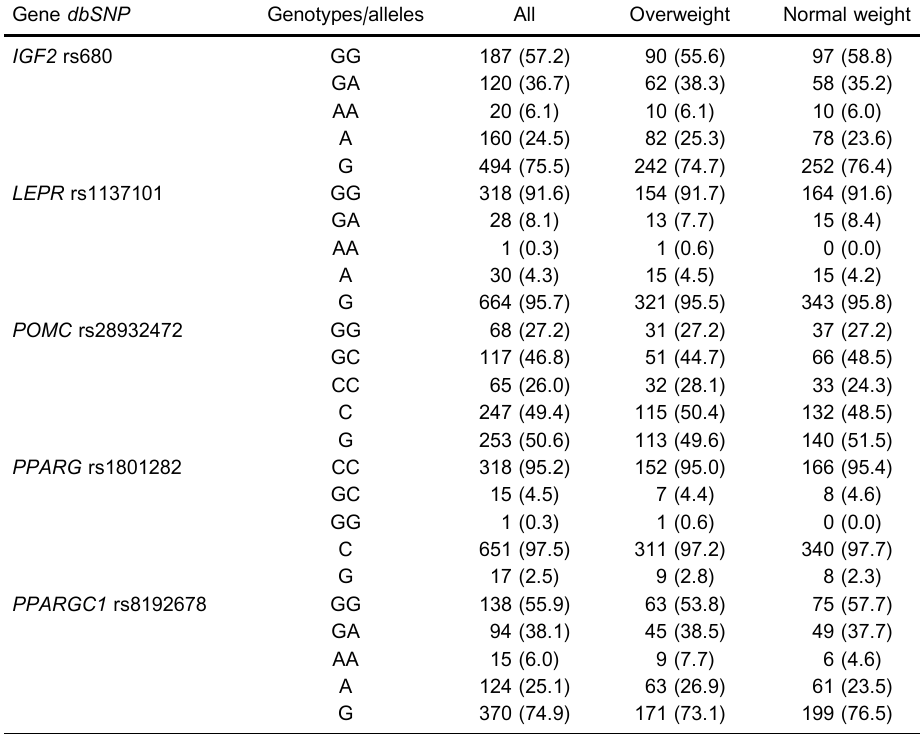
Table 2. Single-nucleotide polymorphism (SNP) genotypes and alleles frequencies in overweight and normal-weight individuals. Gene